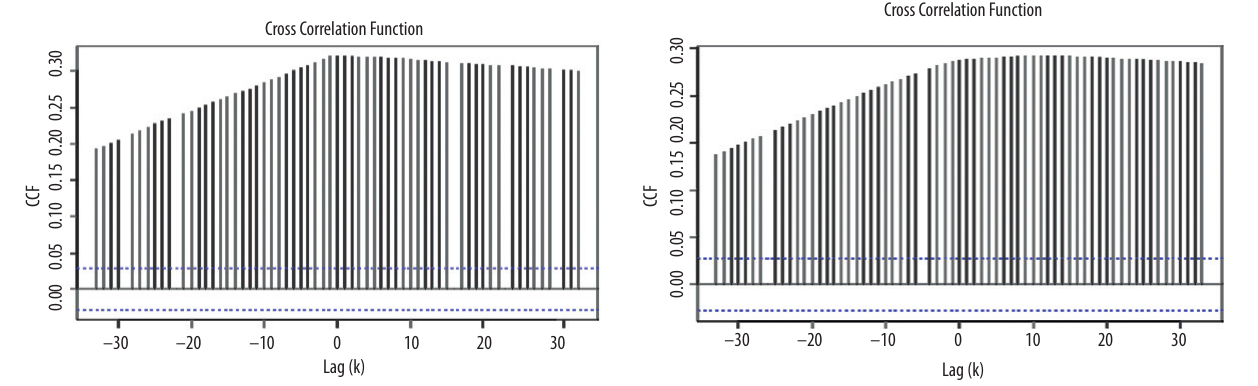
Fig. 8. CCF between Germany’s securitized real estate index and its corresponding Shiryaev-Zhou index